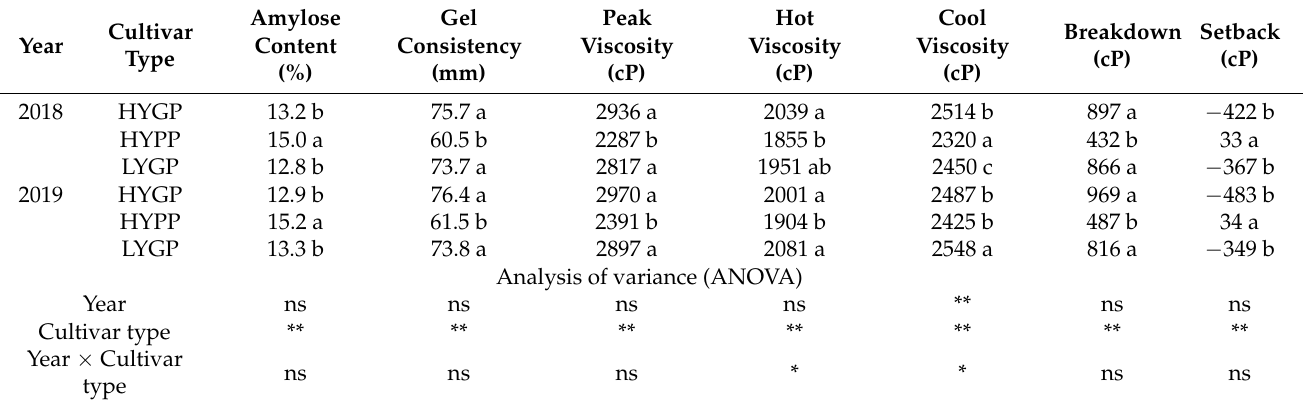
Table 6. Amylose content, gel consistency, and RVA spectrum characteristics of rice cultivar